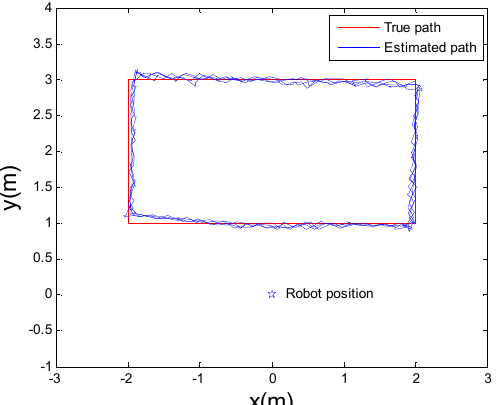
Figure 6. Comparison of ground truth and estimated track for 4× 2m with a simple rectangular trajectory.